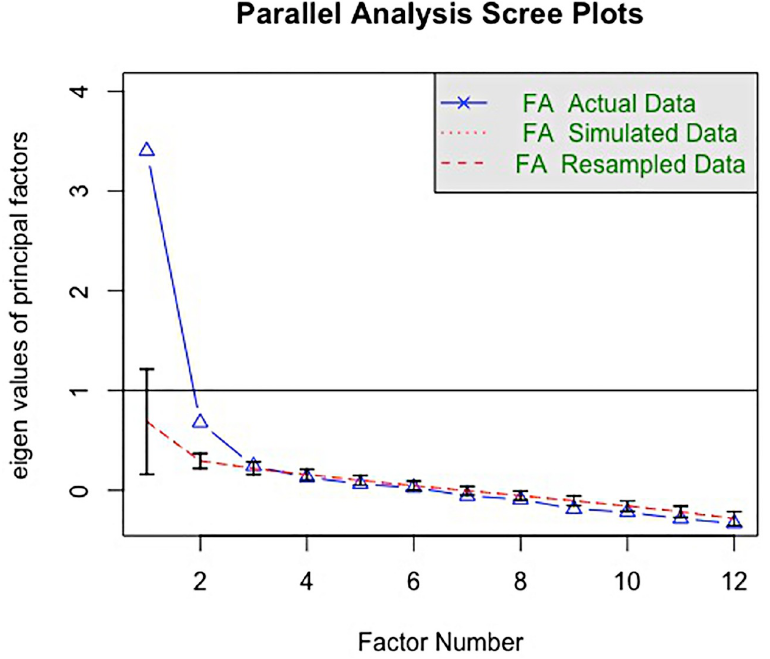
Fig 1. Parallel analysis and Scree Plots of the race-related attitudes and multiculturalism scale. The triangles indicate the factors’ eigenvalues extracted from the study data. The dashed lines and 95% CI indicate the factors’ eigenvalues extracted from the 1,000 simulated and resampled datasets. FA stands for factor analysis.